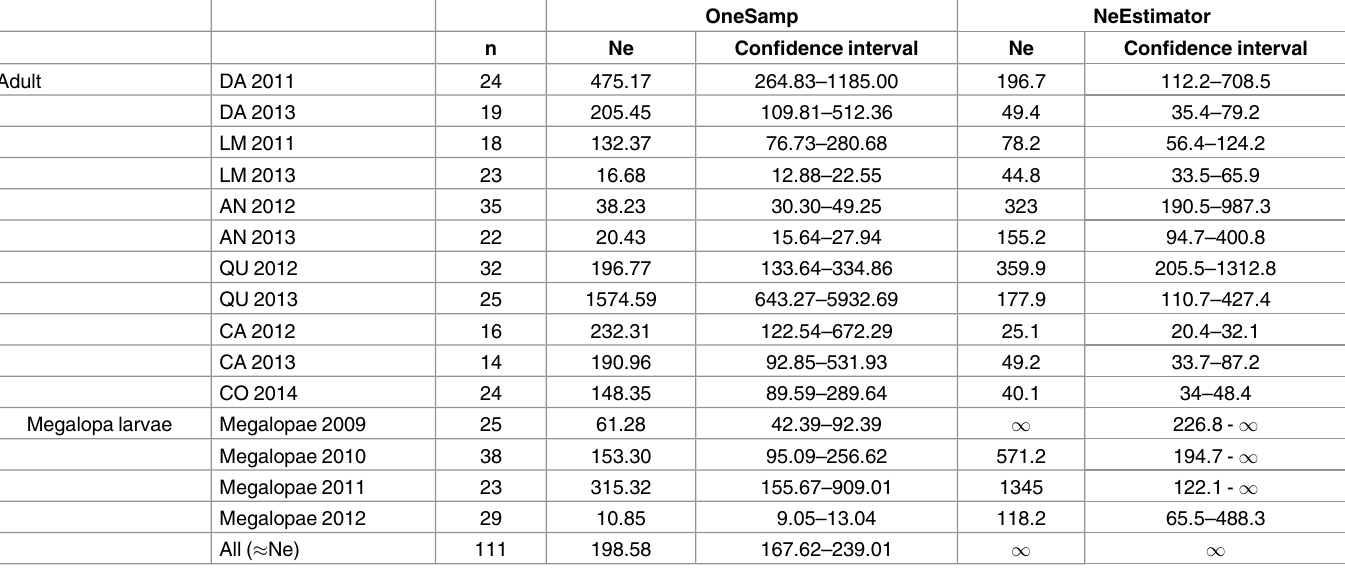
Table 2. Nb and Ne estimated with ONeSAMP and NeEstimator for adults and megalopae collected from the different sampling sites and years. OneSamp NeEstimator n Ne Confidence interval Ne Confidence